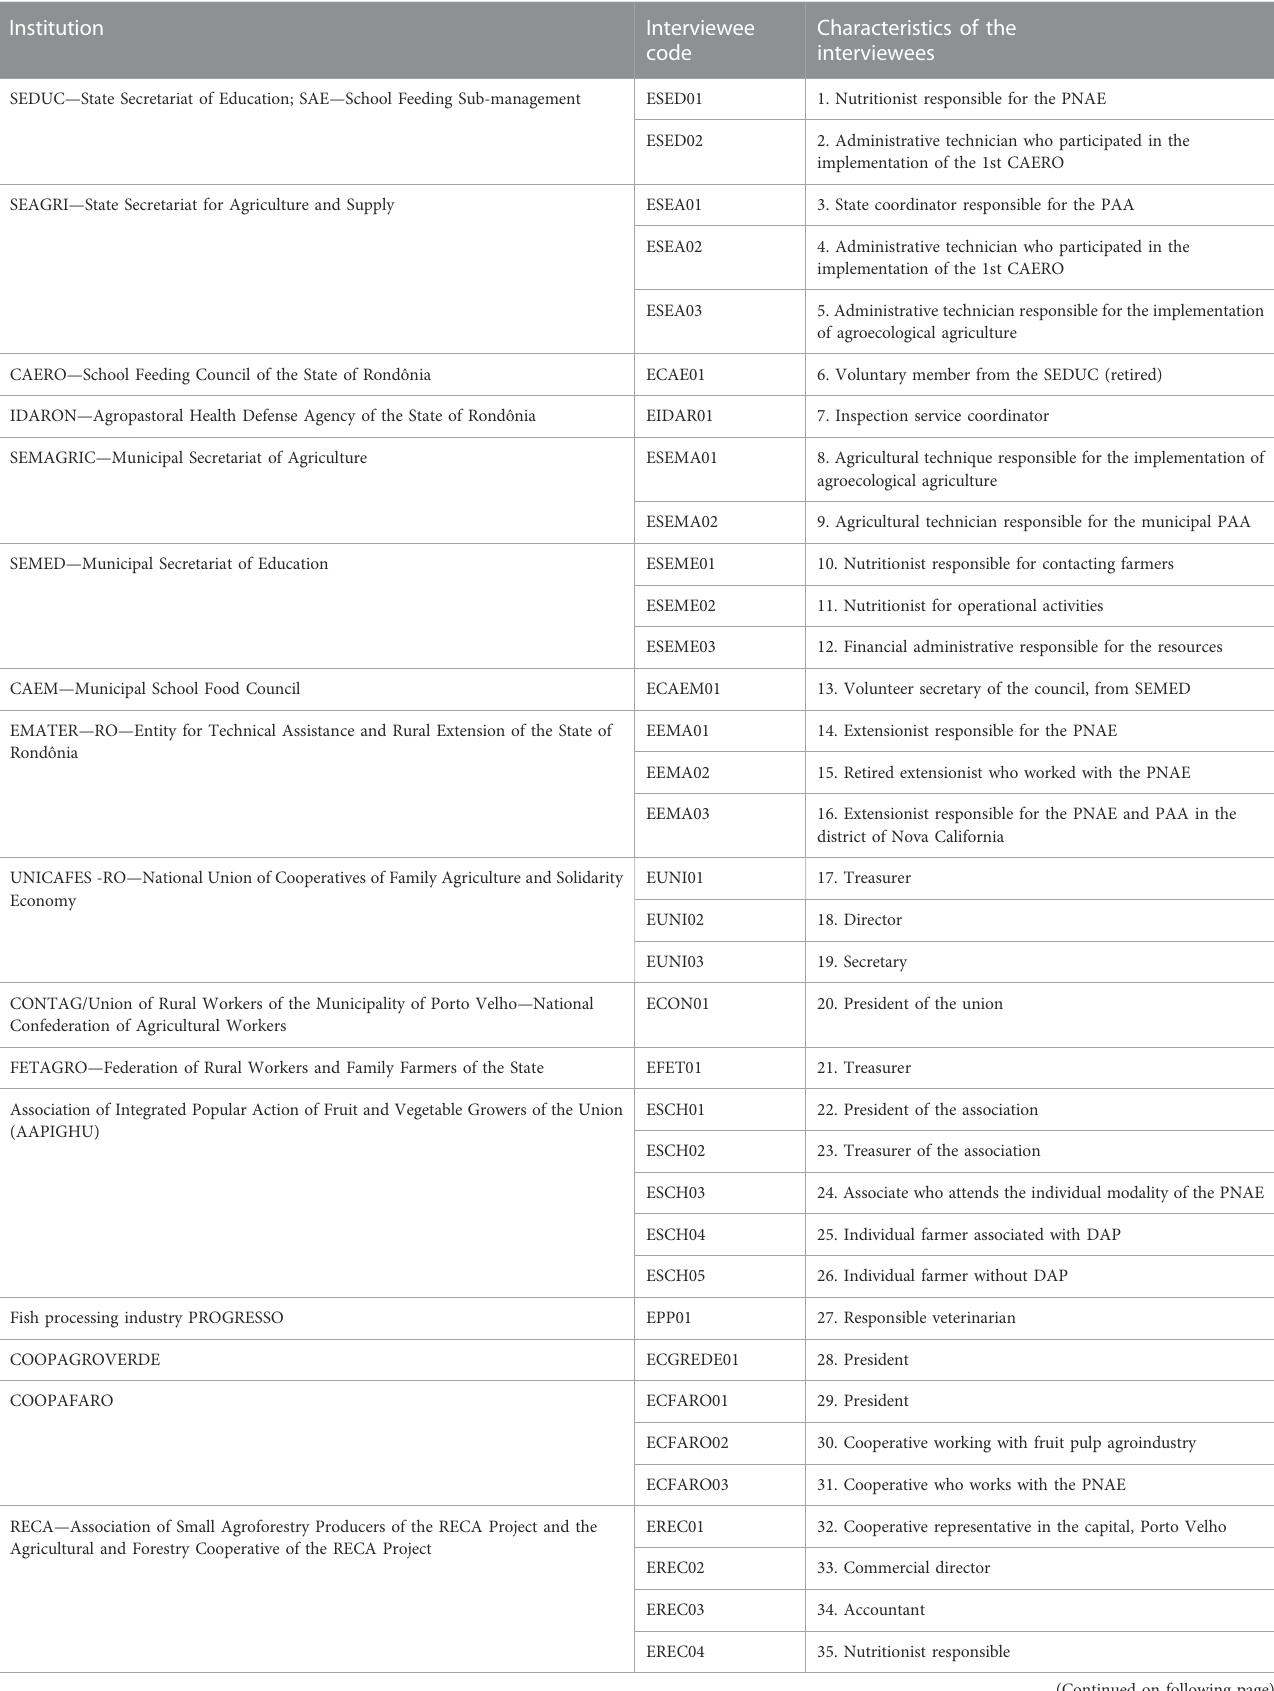
TABLE 1 Interviewees, institutions, and functions that interact in the PNAE (National School Feeding Program) in the municipality of Porto Velho, State of Rondônia, Brazil.